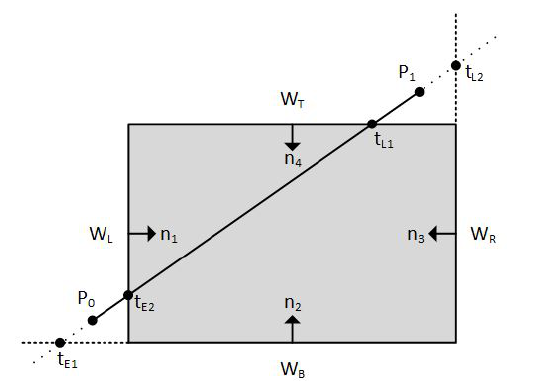
Figure 6. Classifying intersection points either as Potentially Entering (PE) or Potentially Leaving (PL) and calculating their t parameter,